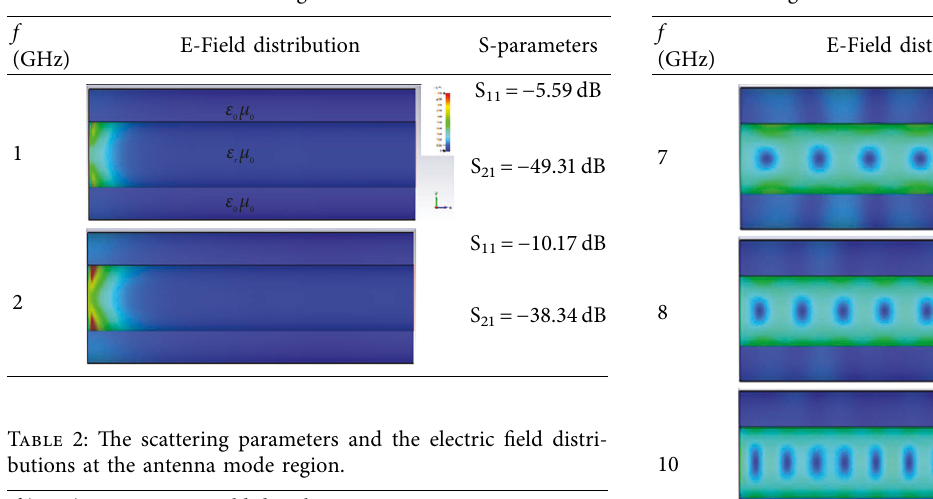
Table 1: The scattering parameters and the electric field distri- butions at the reactive mode region.